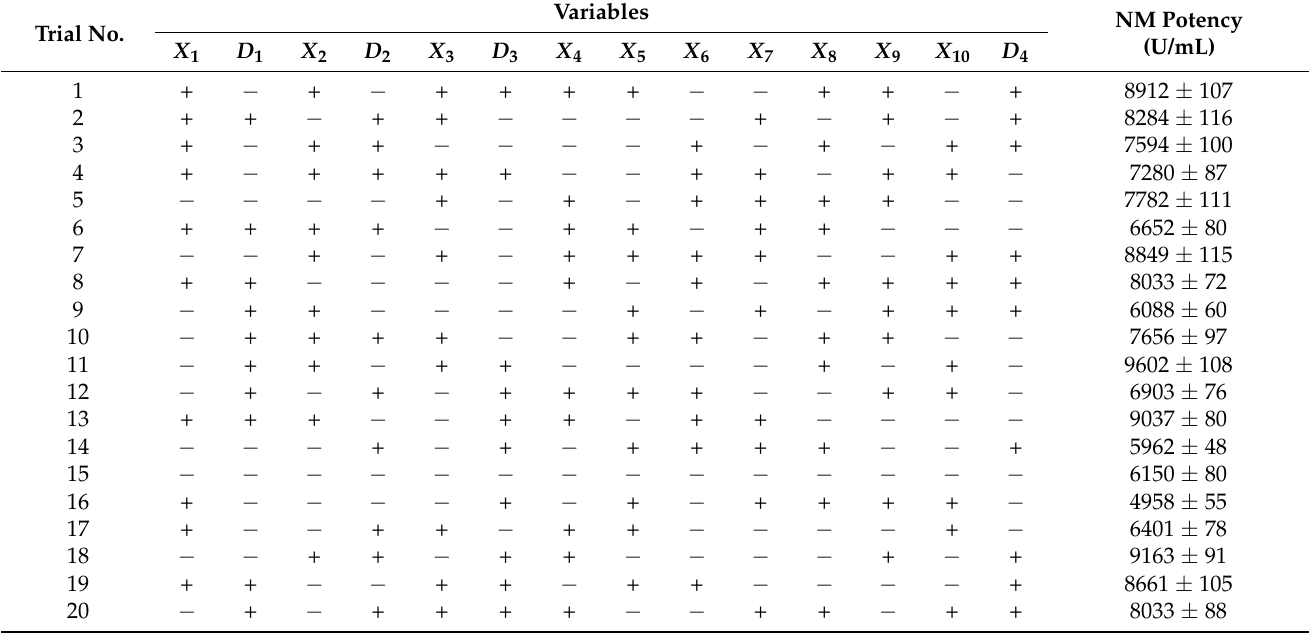
Table 3. Plackett-Burman design matrix with corresponding results. X 1 – X 10 : independent variables; D 1 – D 4 : dummy variables; (+): high level; ( − ): low level.